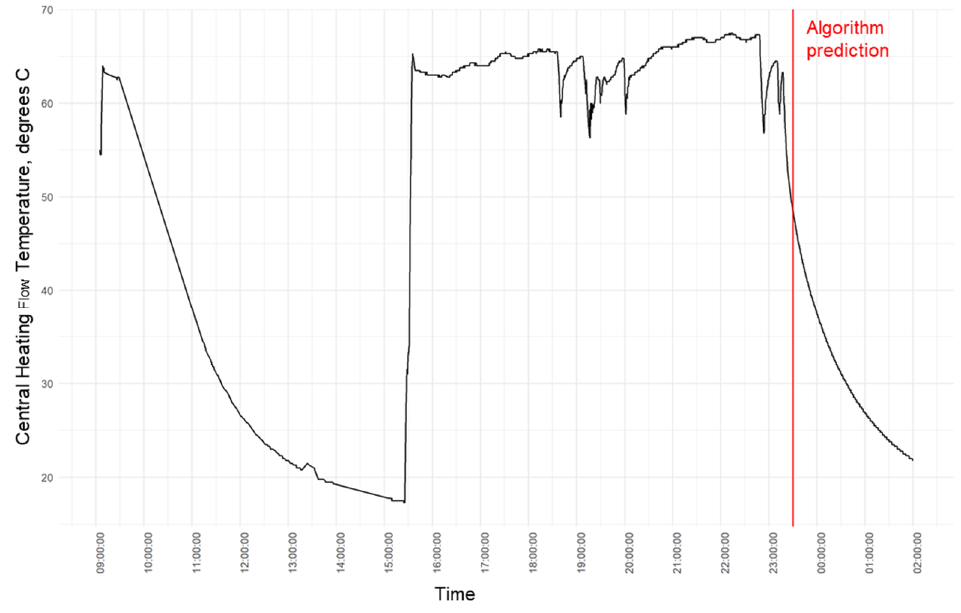
Figure A1. Comparison of the algorithm’s output to the ground truth for IDEAL home no. 135. Heating operation algorithm correctly predicts time of final heating switch off, to the nearest half hour.